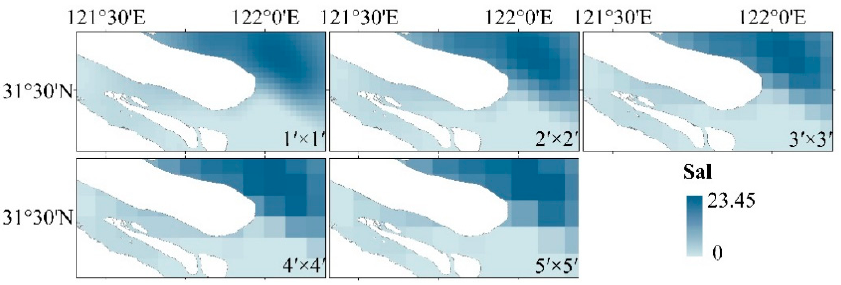
Figure 4. Spatial distribution of the salinity with different spatial resolutions in the autumn of 2014 of the Changjiang River